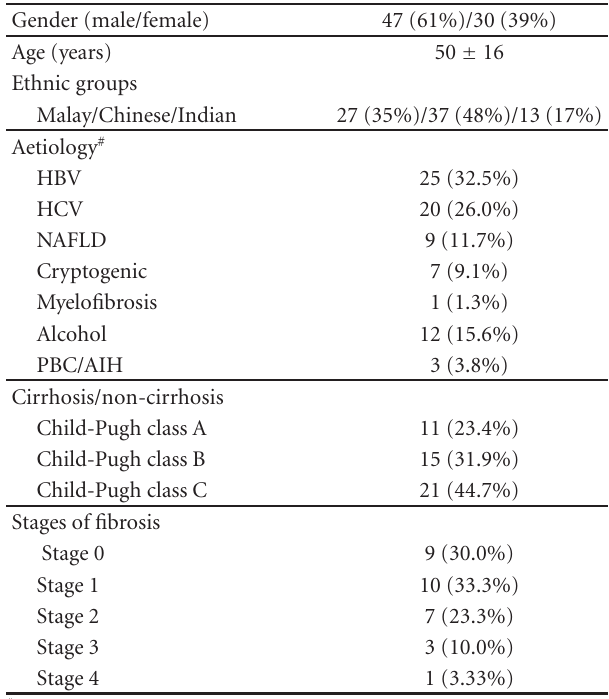
Table 1: Baseline characteristics of the studied population ( n =